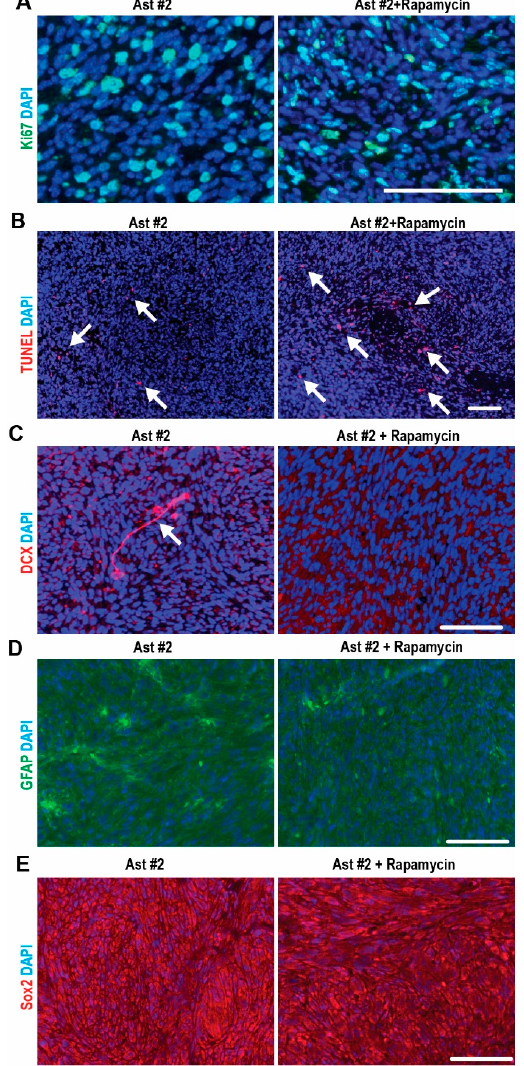
Figure 5. mTORC1-dependent and -independent differentiation in Ast #2 tumors. ( A – E ) Immunofluorescent staining Ki67 ( A ), TUNEL ( B ), DCX ( C ) GFAP ( D ), Sox2 ( E ) and DAPI of Ast #2 tumors treated with vehicle or Rapamycin for 2 weeks. Arrows in B indicated TUNEL-positive cells and arrows in C indicated DCX-positive cells. Bar = 50 µm.